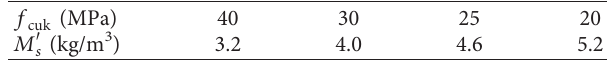
s ′ at 0.1km from the coast.